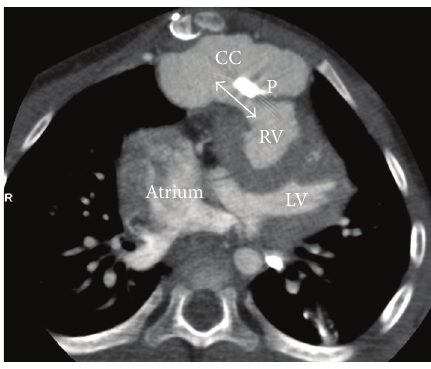
Figure 4: Pseudoaneurysm after surgical repair. ECG-triggered volumetric contrast-enhanced cardiac CT (AquilionONE, Toshiba medical systems) acquired during systole within a single heart beat at a heart rate of 109 beats per minute, in 2 years female patient. Image in transverse orientation. Large precardiac contrast collection (CC)with open connection (two-sided arrow) to the right ventricle (RV), at the site of RV patch (P). CT differential diagnosis was RV patch aneurysm or pseudoaneurysm. Surgery confirmed pseudoaneurysm. Dose-length product of the CT scan was 18.2 mGy ⋅ cm. Correction factor for chest CT at 100kV for 2 years age was 0.044mSv ⋅ mGy −1 ⋅ cm −1 ; effective dose 𝐸 was